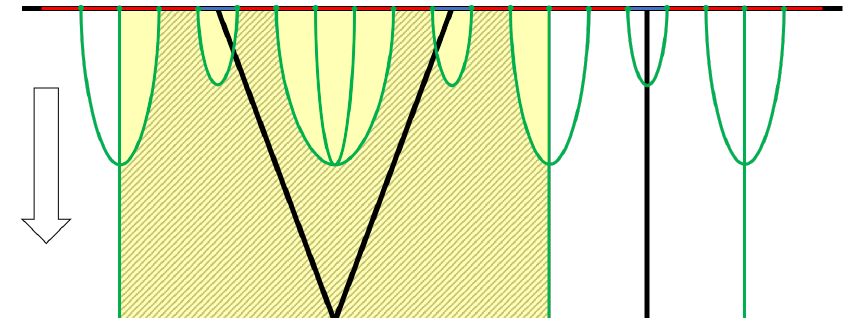
Figure 12: Stretched representation of a layer of tiles (delimited by black segments) in a { 8,4 } tiling of the Poincaré disk and the corresponding TN (green lines) intro- duced in Sec. 5.1. The upper and horizontal lines are called UV and IR chains, respec- tively. Vertices a , b of the tiling, which correspond to weak and strong bonds J on the spin chain according to Fig. 4, are represented in this figure as (horizontal) edges. The RG direction is indicated by the arrow. The yellow region encompasses the letter sequence that is renormalized, while the gray striped region highlights those couplings which effectively enter the RG flow algorithm given in